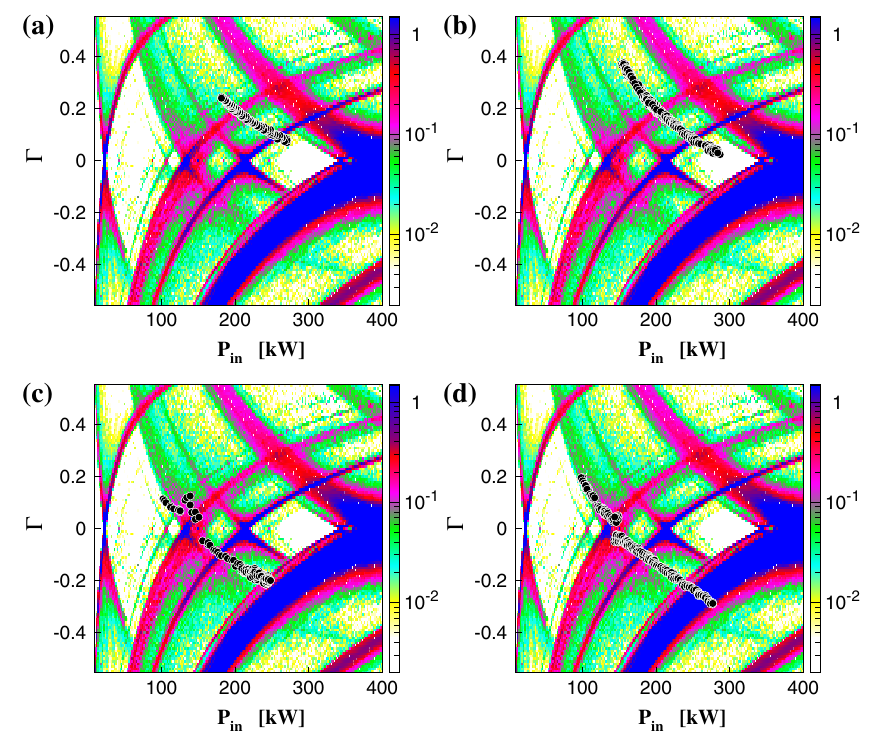
FIG. 16. Trajectories of the operating point of CavityM, superimposed on the multipactoring zone map for the ARES cavity with the ungrooved coupler: M from [18]. The map is asymmetric between the overcoupling and undercoupling regions. The black circles indicate measurements of the input rf power and the reflection coefficient (a) in the overcoupling region without grooves on the outer conductor of the coaxial line, (b) in the overcoupling region with grooves, (c) in the optimum-coupling and undercoupling regions without grooves, and (d) in the optimum-coupling and undercoupling regions with